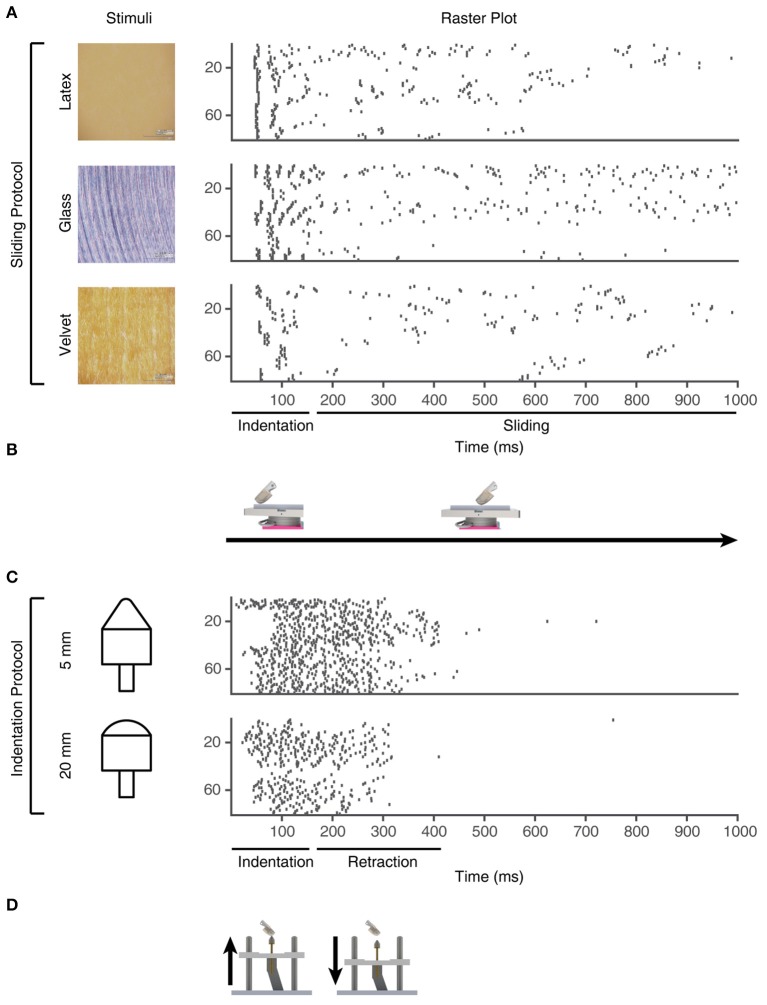
Training stimuli. Physical stimuli and corresponding sensor spiking responses in PA sensory inputs #1-80 for the training stimuli used in the learning process. (A) Three of the physical stimulus conditions consisted in the artificial fingertip first indenting and subsequently sliding across surfaces with different textures, as shown in (B). (C) The two indentation stimuli, where the artificial fingertip was dynamically indented against two different shapes, as shown in (D).